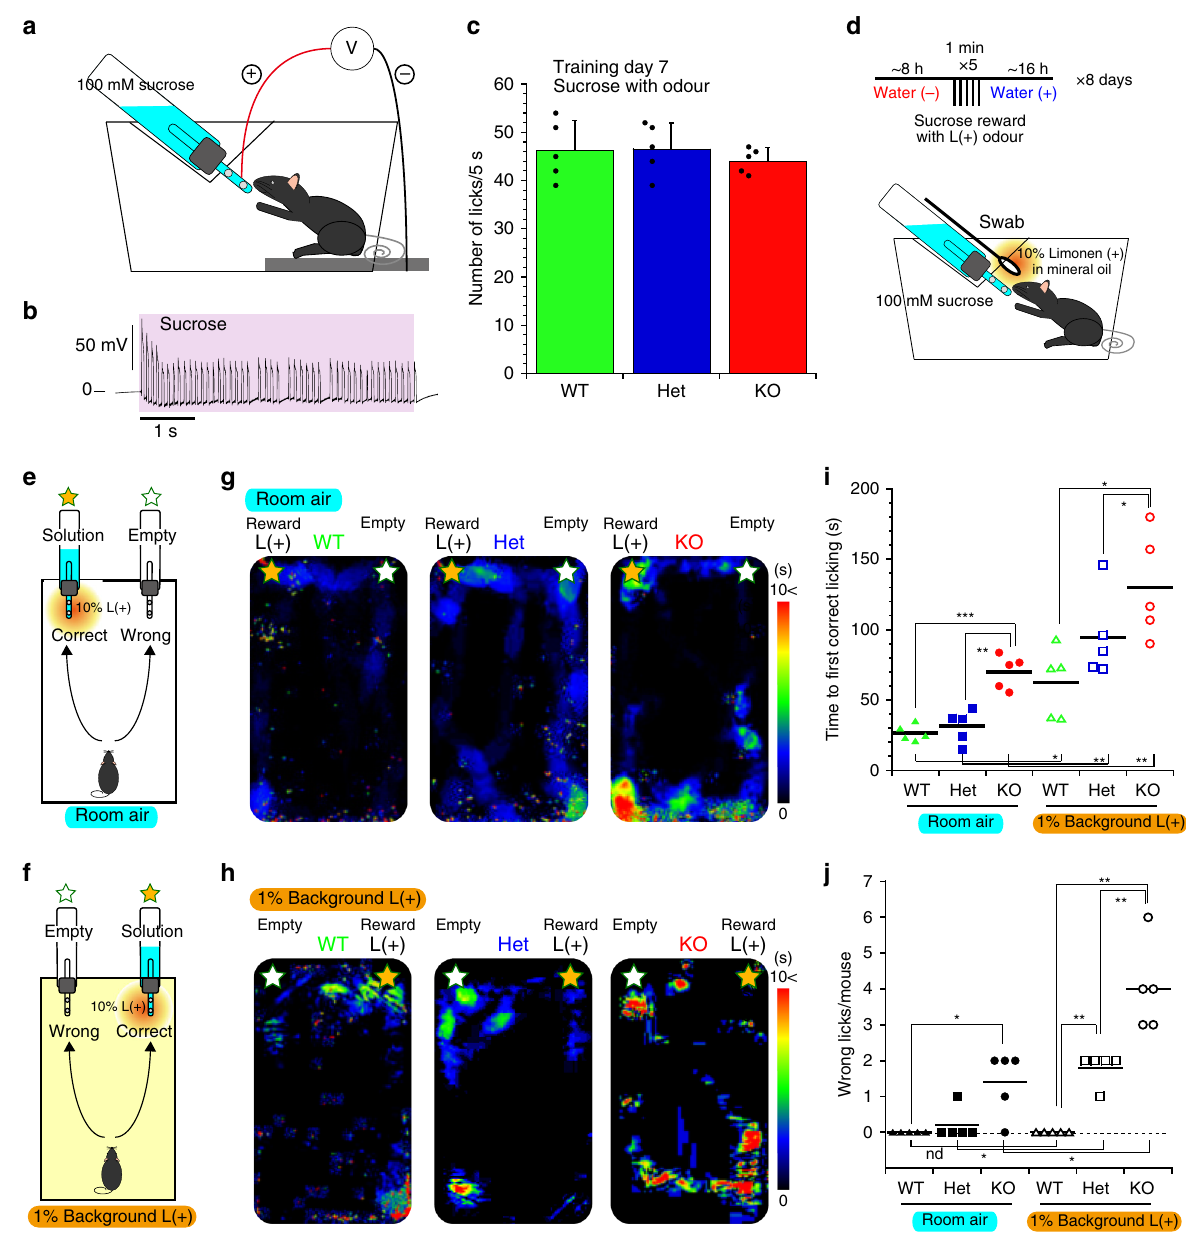
Fig. 8 OMP-de fi cient mice lose olfactory sensitivity to background odours. a The sucrose preference measurement by a licking metre. b Preference of mice for sucrose. Licking was counted for 5 s from the fi rst lick. c Summary of licks during 5 s. Mean ± s.d. d Training paradigm to associate a sucrose reward with the limonene-( + ) odour. A swab containing L( + ) was presented with a sucrose solution. e , f Schemes of 10% L( + )-odour-source searching associated with a sucrose reward in ( e ) room air and ( f ) an atmosphere with a 1% L( + ) background odour. g , h Representative heatmaps of the times mice spent reaching and licking the correct spout with the sucrose reward. Bottles with or without a reward were switched in different sessions ( g , f ). i Time to the fi rst correct licking of the reward bottle. j The number of wrong licks of the empty bottle before the fi rst correct lick. Means are shown in black bars in ( i , j ). n = 5 each for WT, Het and KO in ( c , i , j ). * P < 0.05; ** P < 0.01; *** P < 0.001. Statistics: room air; i one-way ANOVA and post hoc Bonferroni test; F (3, 12) = 27.26, P < 0.0001 and P WT vs Het > 0.999, P WT vs KO < 0.0001, P Het vs KO = 0.0002. j Kruskal – Wallis test; P = 0.018. The Mann – Whitney U test for further comparison; P = 0.42, P = 0.023, P = 0.053. Background odour; i one-way ANOVA and post hoc Bonferroni test; WT vs Het WT vs KO Het vs KO F (3, 12) = 5.85, P = 0.017 and